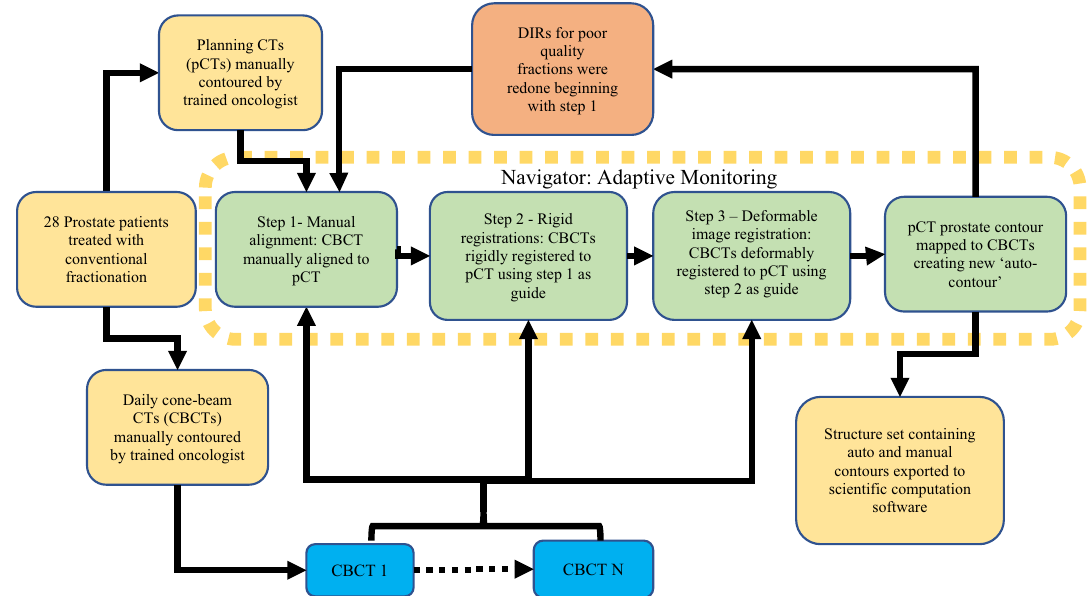
Figure 1. Deformable image registration and delineation propagation workflow. All steps included in the Adaptive Monitoring Navigator on Velocity are inside the dotted-line box. The re-evaluation of poor-quality fractions (DSC < 0.75, MDA > 3.5 mm) is shown in the light-red box. Exportation of data to MATLAB for data extraction and analysis is done in the final green